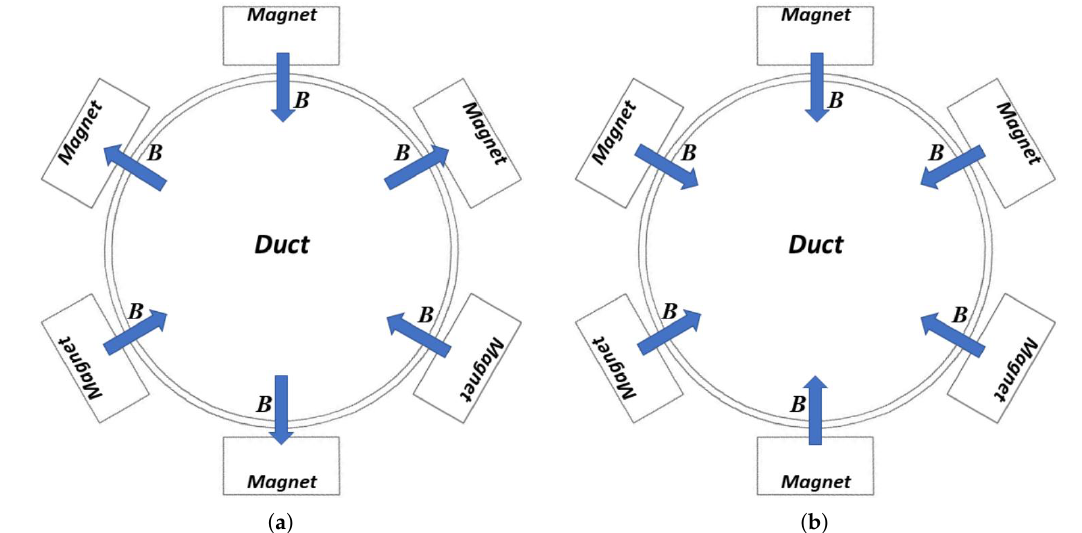
Figure 2. Cross-sectional view of the duct and magnets around it in the ( a ) attractive and ( b ) repulsive